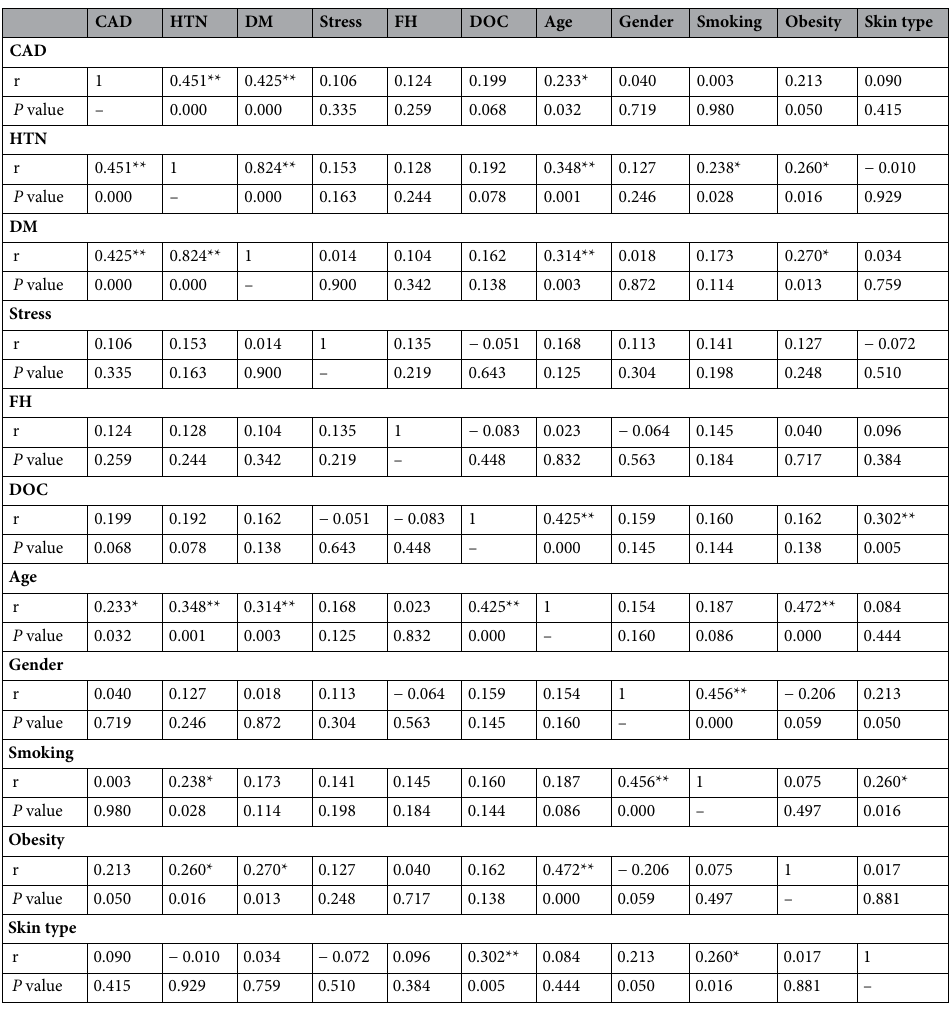
Table 7. Correlation analysis of vitiligo risk factors in the study. Spearman’s Correlation coefficient are presented for different clinical characteristics among vitiligo patients’ understudy. Significant values are highlighted. **Correlation is significant at the 0.01 level (2-tailed). *Correlation is significant at the 0.05 level (2-tailed). CAD coronary artery disease, DOC duration of complain, Distri. distribution, DM diabetes mellitus, FH family history, HTN